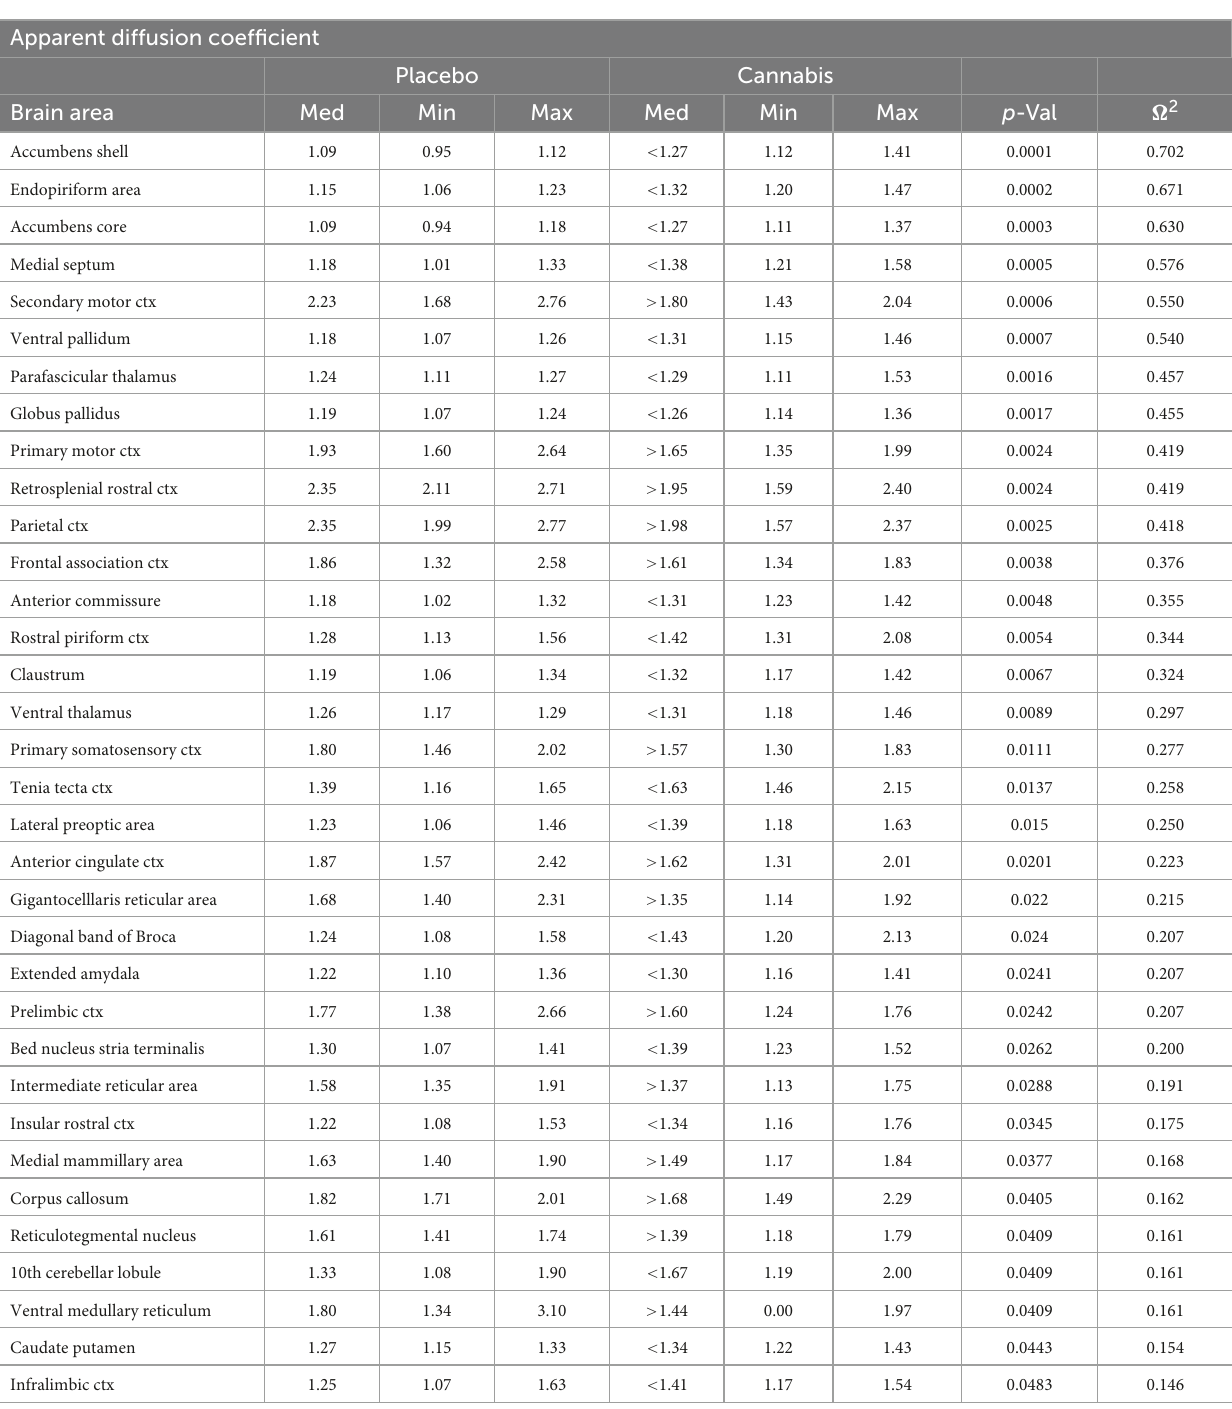
TABLE 2 Apparent diffusion coefficient.